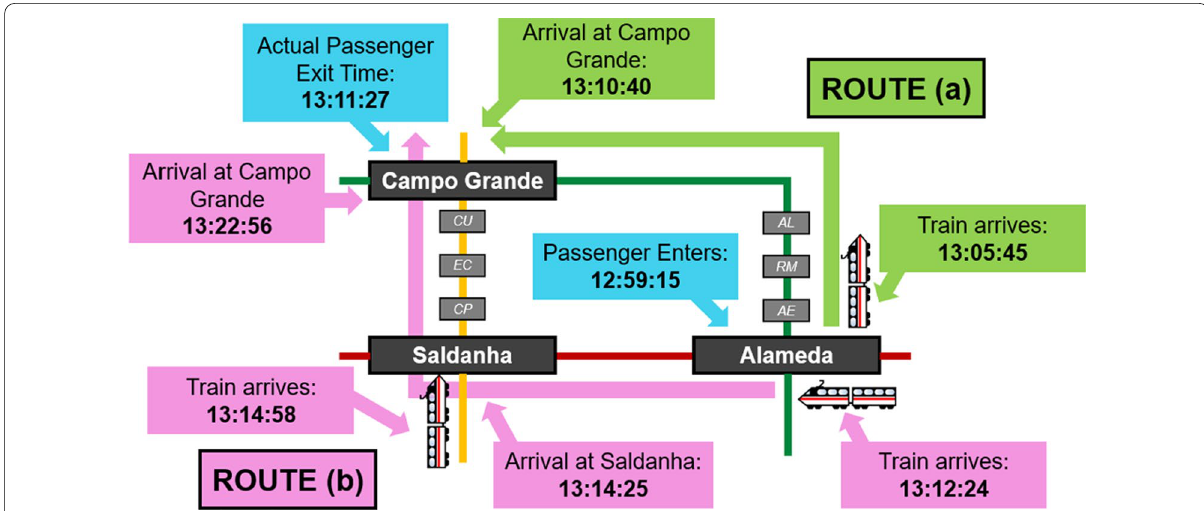
Fig. 7 Two possible routes from Alameda to Campo Grande, shown in light green ( a ) and pink ( b ). It is more likely that the passenger took route ( a ) based on the distance between the expected arrival at Campo Grande and the actual exit time